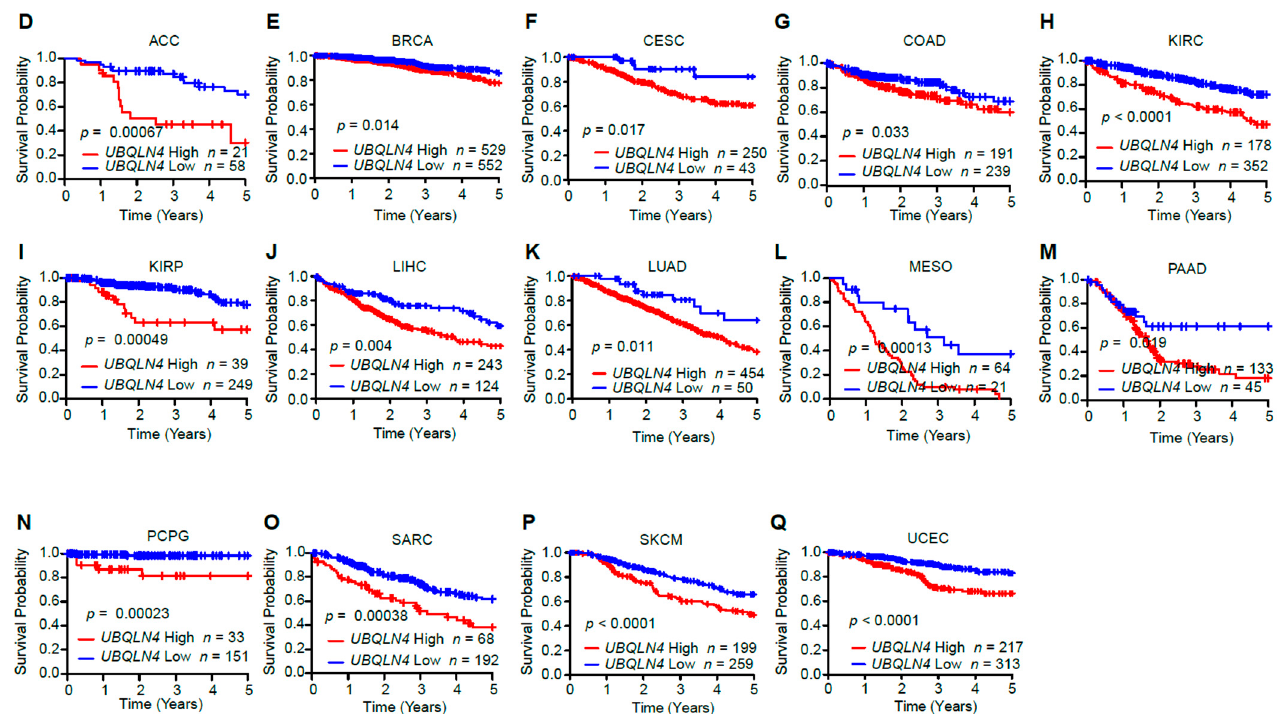
Figure 1. UBQLN4 mRNA levels are upregulated in various types of solid tumors. ( A ) UBQLN4 mRNA levels in tumor tissues (TCGA dataset) and normal tissues (GTEx dataset). Statistical differ- ences were calculated by the Mann–Whitney U test. ( B ) UBQLN4 mRNA levels in tumor and adjacent normal tissues from TCGA dataset. Statistical differences were calculated by the Mann–Whitney U test. ( C ) UBQLN4 protein levels in paired tumor and adjacent normal tissues from BRCA, OV, LUAD, ESCA, CESC, BLCA cancers. IHC analysis in the TMA were performed with UBQLN4 mAb (1:100). The insets represent the whole image of the core in the TMA. Scale bars = 200 µm. The magnifications represent an enlarge image of a specific site in the cores of the TMA. Scale bars = 200 µm. ( D – Q ). Kaplan–Meier curves for ACC, BRCA, CESC, COAD, KIRC, KIRP, LIHC, LUAD, MESO, PAAD, PCPG, SARC, SKCM, and UCEC patients according to UBQLN4 mRNA expression in TCGA datasets. Statistical differences were evaluated using the log-rank test. Abbreviation lists can be found in the materials and methods